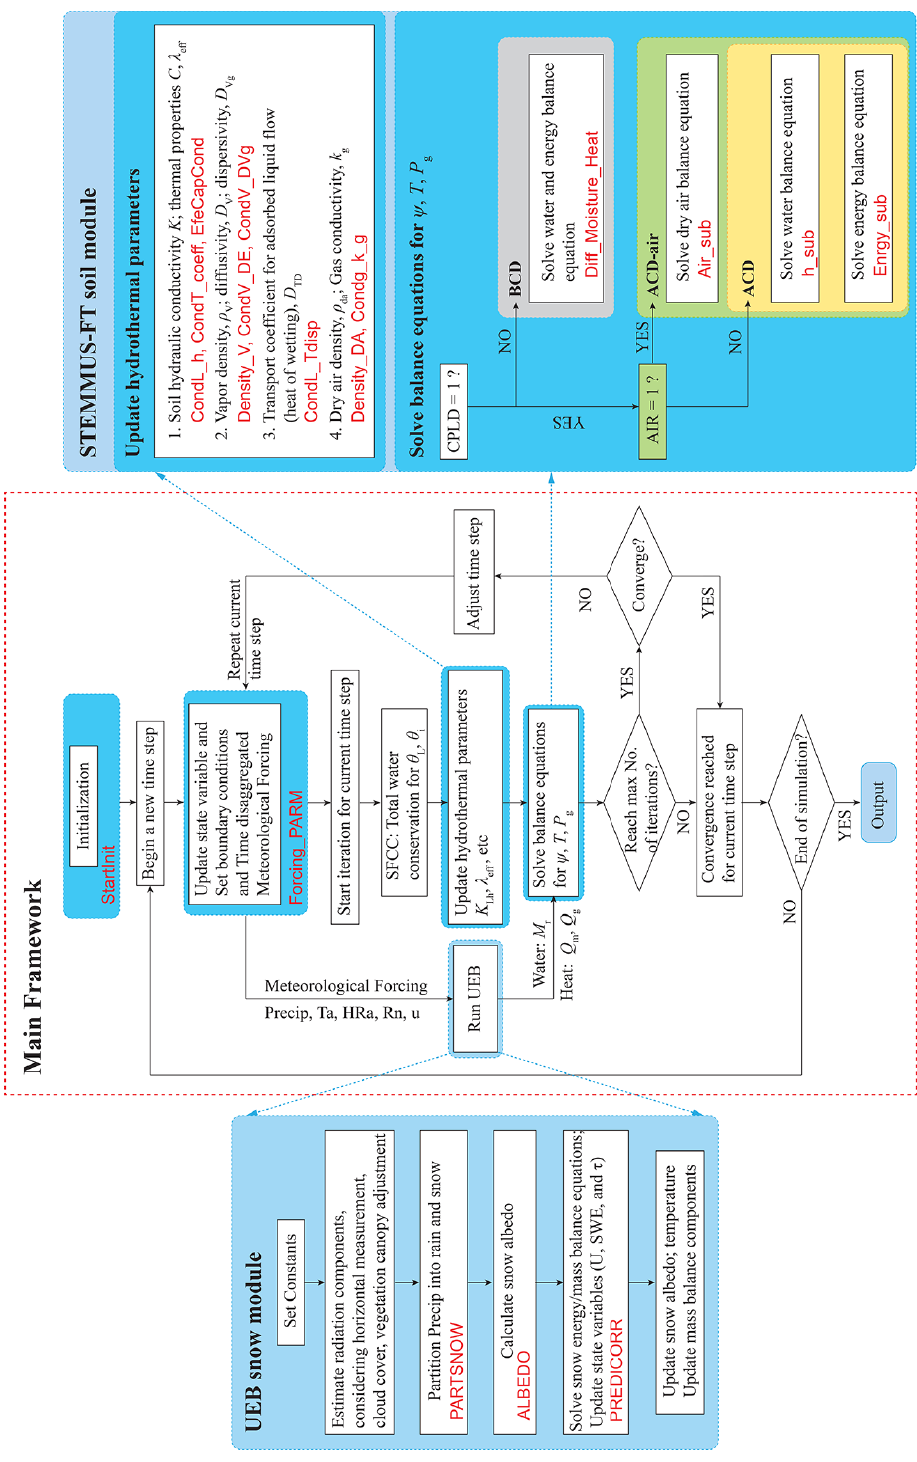
Figure 1. The overview of the coupled STEMMUS-FT and UEB model framework and model structure. SFCC is soil freezing characteristic curve, θ L and θ i are soil liquid water and ice content, K Lh is soil hydraulic conductivity, and λ eff is thermal conductivity. ψ,T,P g are the state variables for soil module STEMMUS-FT (matric potential, temperature, and air pressure, respectively). U, SWE, and τ are the state variables for snow module UEB (snow energy content, snow water equivalent, and snow age, respectively). UEB is the Utah energy balance module. Precip, Ta, HRa, Rn, and u are the meteorological inputs (precipitation, air temperature, relative humidity, radiation, and wind speed, respectively). M r is the snowmelt water flux, Q m is the convective heat flux due to snowmelt water, and Q g is the heat conduction flux. Model subroutines are in